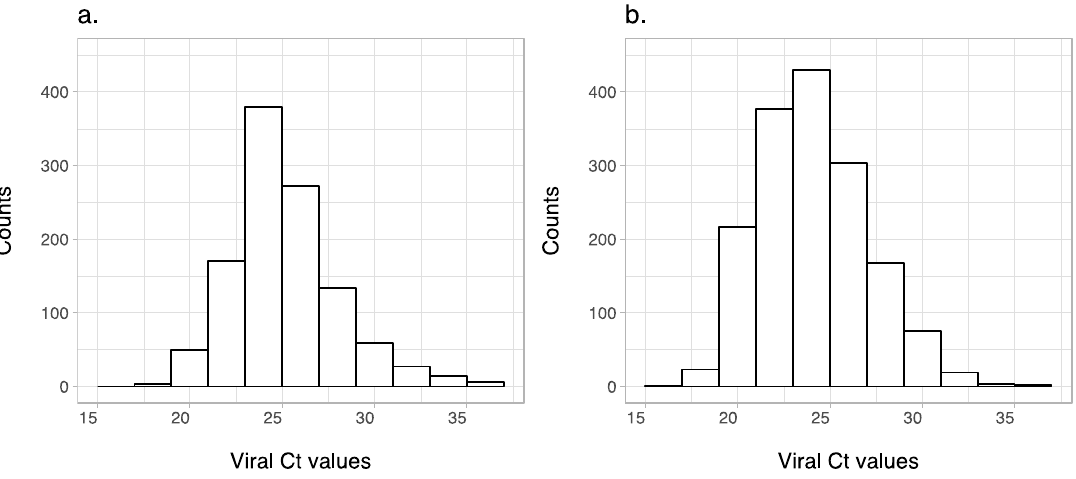
Figure 1. Cycle threshold ( Ct ) values of Piscine myocarditis virus (PMCV) loads detected from the heart of infected fish from ( a ) SalmoBreed and ( b ) StofnFiskur populations. Note that Ct values are inversely related to the level of the virus detected from the tissue.